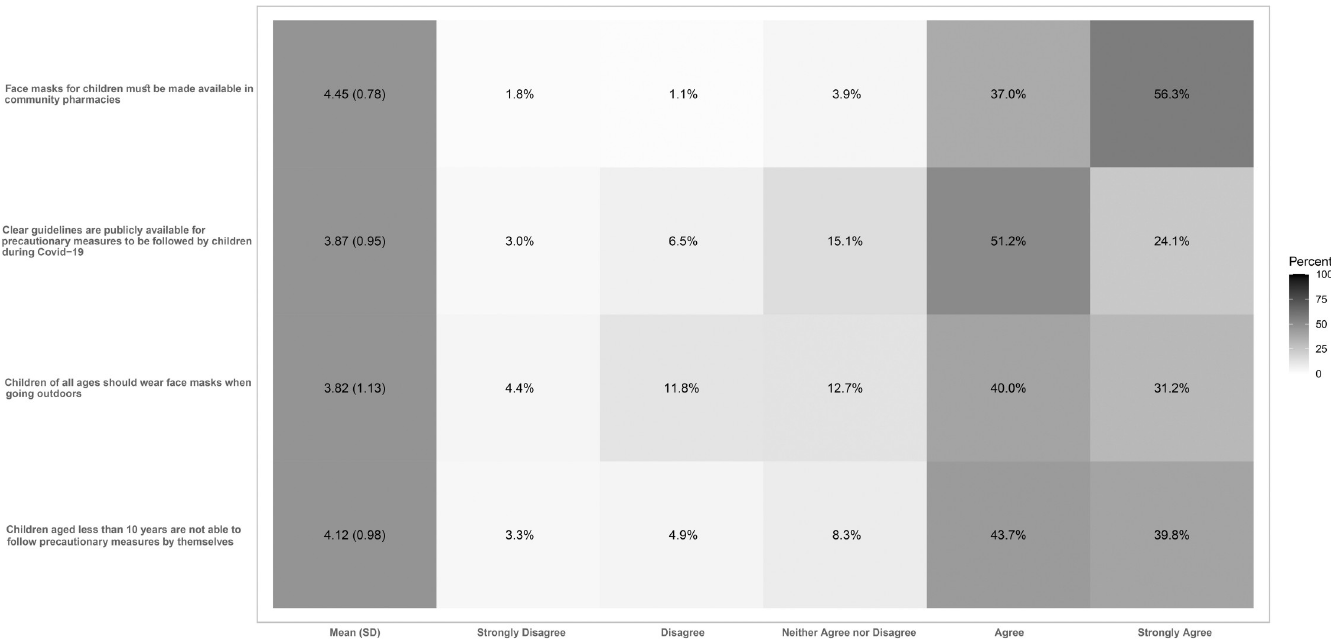
Fig 2. Mothers’ (n = 564) perceptions of information regarding practices to protect children from COVID-19.